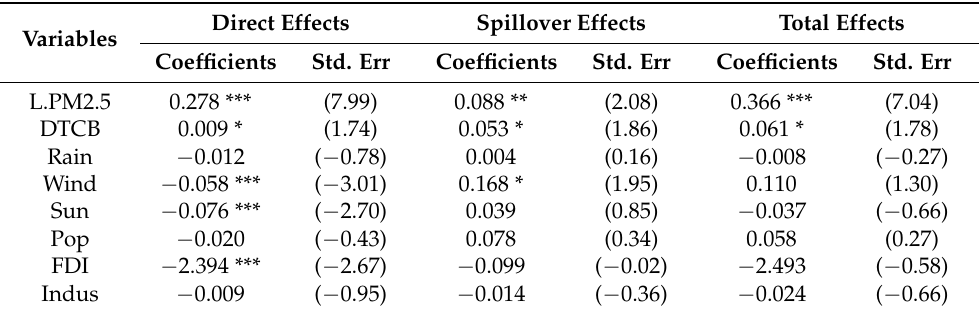
Table 9. The robustness testing of the first order lag term of PM2.5 is introduced into the explana- tory